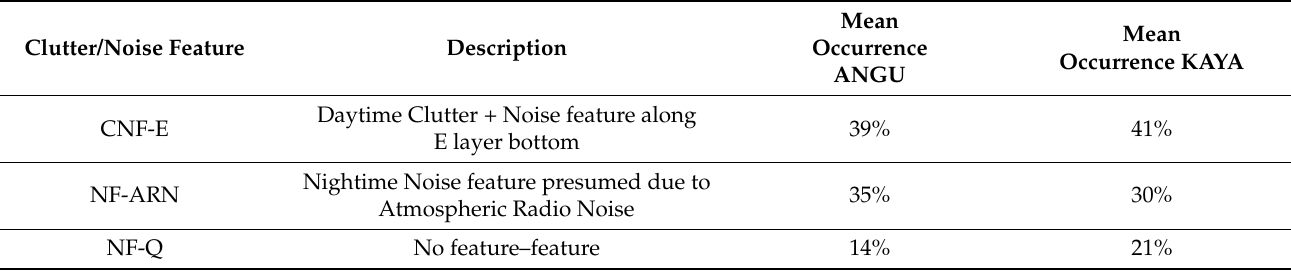
Table 2. Clutter + Noise feature descriptions and mean occurrences at ANGU and